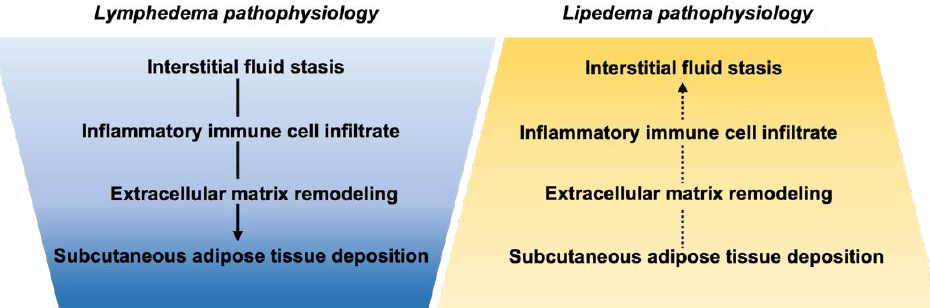
Figure 1. Pathophysiological features of lymphedema and lipedema are represented graphically to emphasize (i) the overlapping pathologies involved in each disease, and yet (ii) their different prominence in disease progression. Pathologies which are most prominent are graphed in the widest section, with fluid being most prominent in lymphedema and adiposity most prominent in lipedema. The time course of these pathologies is potentially reversed, represented by a solid arrow for the well-established disease progression of lymphedema, and a dashed arrow in reverse order for lipedema where adipose tissue or extracellular matrix dysfunction could give way to inflammation and an increased immune response.